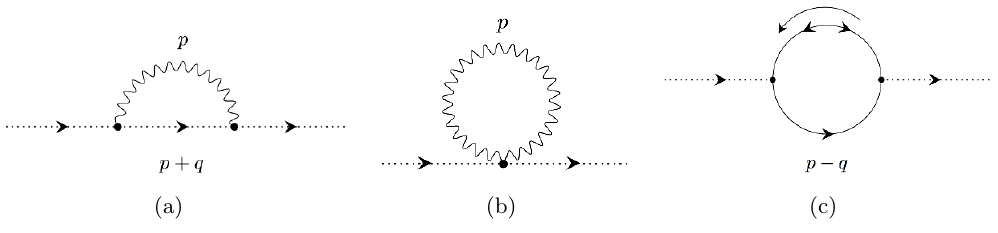
Figure 5 . The selectron self-energy at one-loop in the N = 1